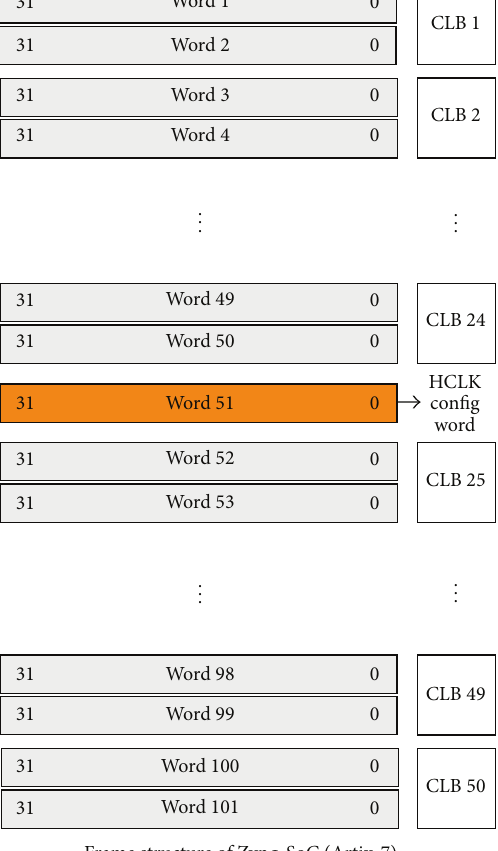
Figure 4: Frame structure of a column based Xilinx Zynq-SoC.